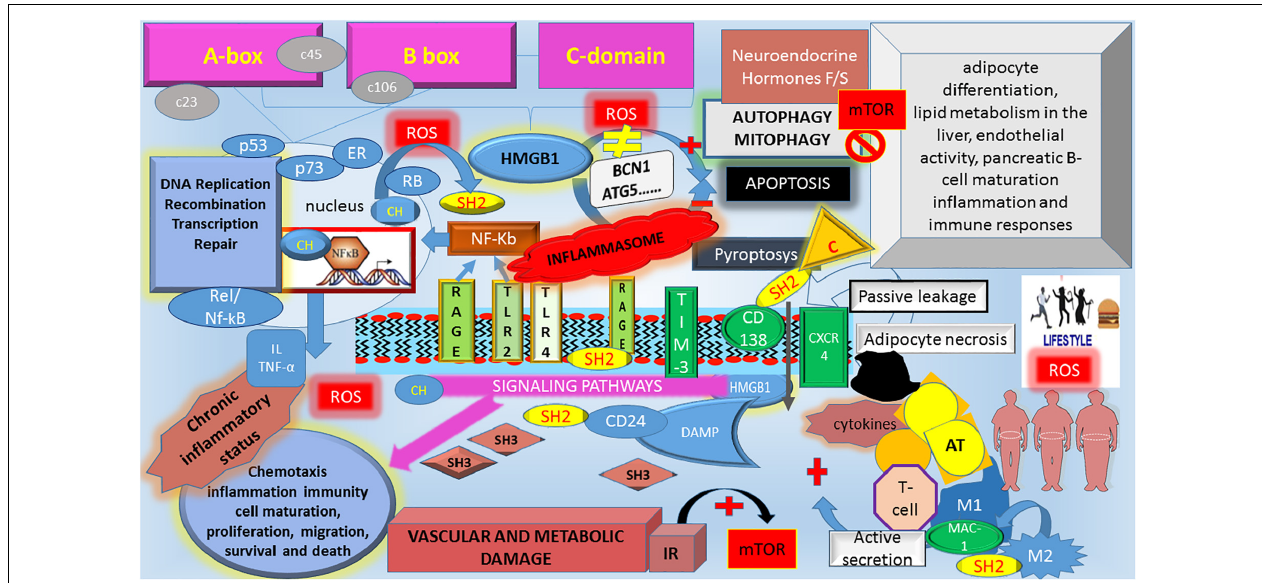
FIGURE 2 | The schematic interplay among HMBG1, autophagy, and Metabolic Syndrome. HMGB1, High mobility group box 1; c23, c46, c106, cysteine at 23, 46, 106 position; ROS, reactive oxygen species; BCN1, Beclin-1; ATG, autophagy-related genes; Neuroendocrine hormones F/S, fasting/starvation; mTOR, mammalian target of rapamycin; NF- κ b, nuclear factor kappa-light-chain-enhancer of activated B cells; IL, interleukines; TNF- α , tumor necrosis factor-alpha; p53, protein 53; p73, protein 73; RB, retinoblastoma protein; Rel/Nf- κ B, member of Rel/Nf- κ B family; ER, estrogen receptor; C, caspases, non-canonical inflammasome; RAGE, advanced glycosylation end product-specific receptor; TLR2 and TLR4, Toll-like Receptor 2 and 4; TIM-3, T-cell immunoglobulin mucin-3; CXCR4, chemokine C-X-C motif receptor 4; Mac-1, macrophage-1 antigen; CD138, syndecan-1; CD24, cluster of differentiation 24; M, macrophages; IR, Insulin Resistance; AT, Adipose Tissue. HMGB1 functions as a Damage Associated Molecular Pattern (DAMP) protein in the extracellular space. A mixture of different HMBG1 isoforms (CH = reduced form; SH2: disulfide HMBG1, SH3 oxidized form) in the extracellular space activates different pathway signaling. As the disulfide HMBG1 is responsible for autophagy activation, which counteracts the metabolic consequences of MetS. During an overload of food nutrients, there is an increase in ROS. The oxidative environment modifies the Reduced/oxidized HMBG1 ratio, increasing the dysregulation in Insulin/mTOR signaling, which blocks the autophagy machinery. It follows an increased risk for the “unhealthy” obese to develop MetS complications due to an unbalance among the downstream IR pathway, chronic inflammatory pattern and inability to counteract metabolic derangements via autophagy machinery disruption. HMGB1 is an autophagic regulator that mediates stress response: in normal condition, cytosolic HMGB1 as BECN1-binding protein induces autophagy. Extracellular HMGB1 binds RAGE, which inhibits mTOR and promotes autophagy. In chronic obesity and switching from insulin-sensitive to IR state, change in oxidative environment modifies the HMBG1 activity altering its inducer role in autophagy. In the nucleus, HMBG1 interact with and enhances the activities of number of transcription factors, including p53, p73, RB, Rel/Nf- κ B, and ER. Once released, HMBG1 binds to various receptors to activate DAMP signaling involved in multiple cellular processes. Inflammasomes are a cytosolic multiprotein complex formation that are recruited by external pathogen and/or internal stimuli. Chronic inflammasomes lead to chronic inflammatory status increasing the risk of clinical consequences of MetS. HMGB1 triggers C (Caspase-4/caspase-5) which are components of the “non-canonical inflammasome” with cytokines release and induction of pyroptosis (a kind of proinflammatory cell death combining features of both apoptosis and